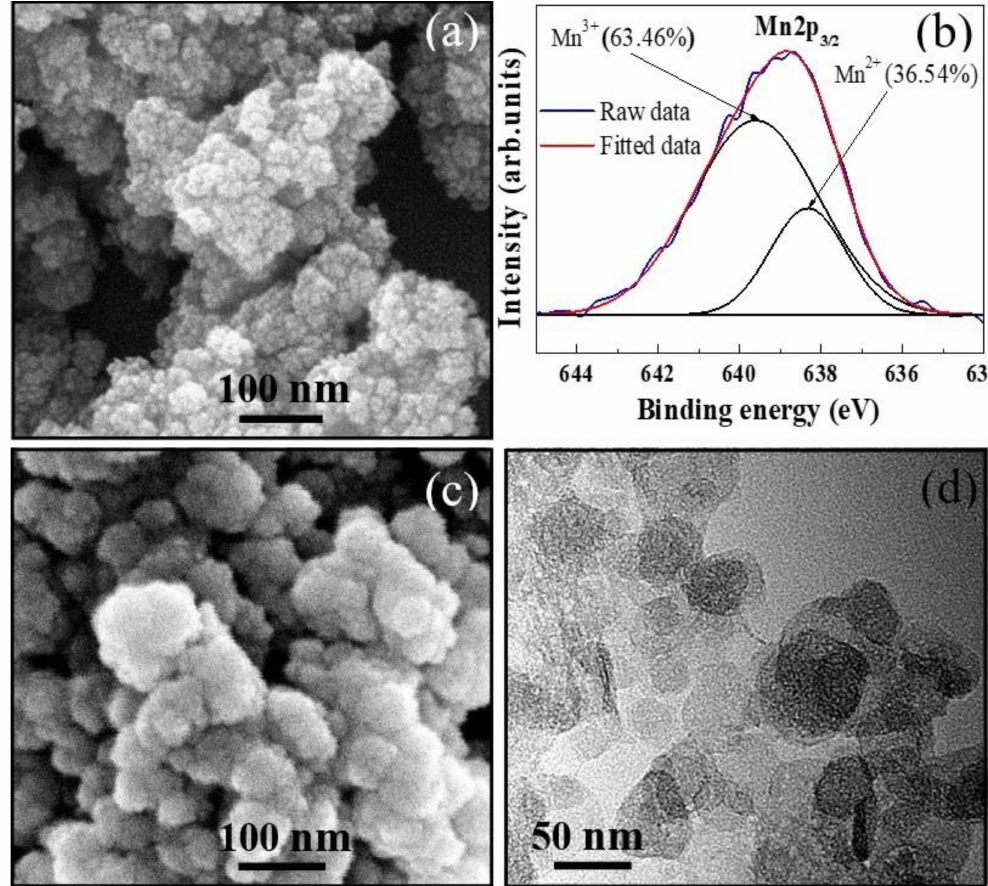
Figure 4. ( a ) FE-SEM image and ( b ) XPS Mn2p 3/2 spectra of as-prepared powder. ( c ) FE-SEM and ( d ) TEM images of powder calcined at 650 ◦